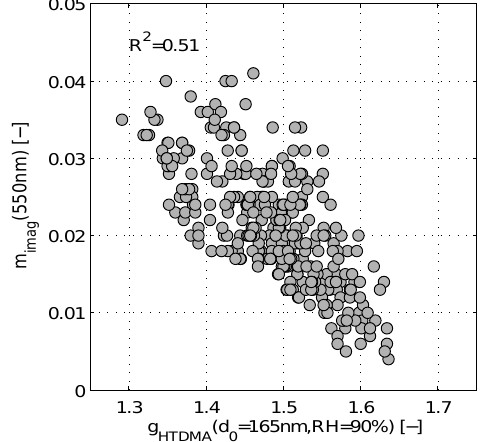
Fig. 4. Retrieved imaginary part of the complex refractive index versus the hygroscopic growth factor measured by the H-TDMA (at d 0 = 165nm and